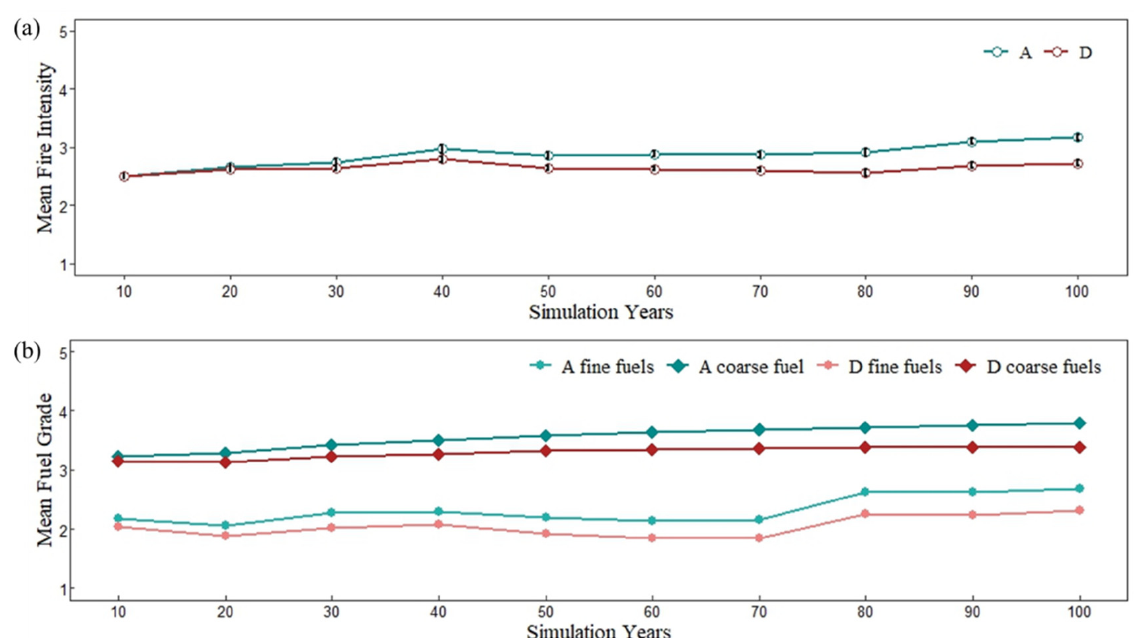
Figure 4. Mean fire intensity ( a ) and mean fuel loads grade ( b ) under scenario A and scenario D.